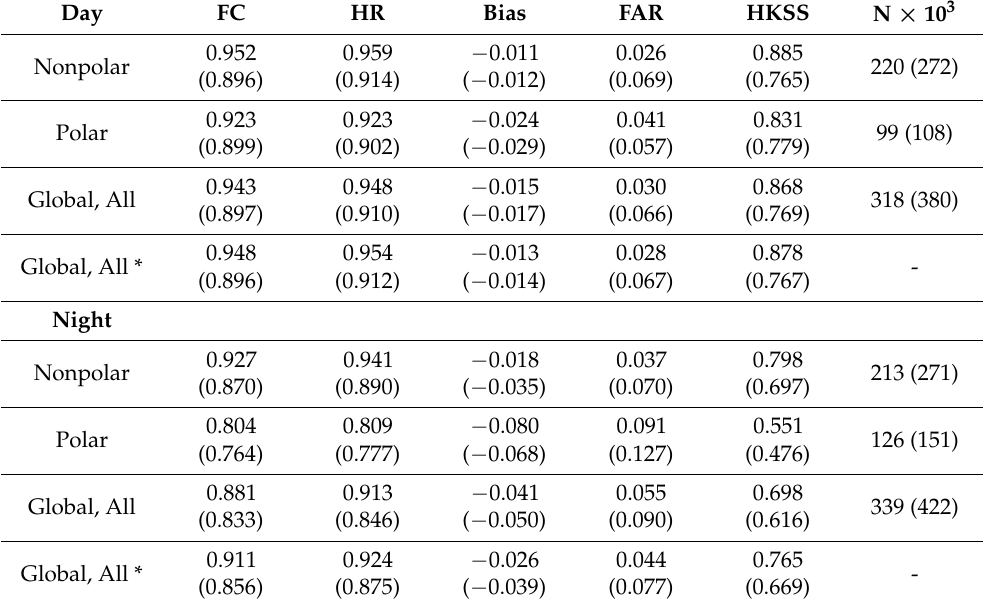
Table 2. Cloud detection metrics determined from confusion matrices of matched CERES SNPP VIIRS Ed1a and CALIOP (HA ≤ 5 km) pixels, JAJO 2015 and 2016 for 0/100 cases and 50/50 cases, shown in